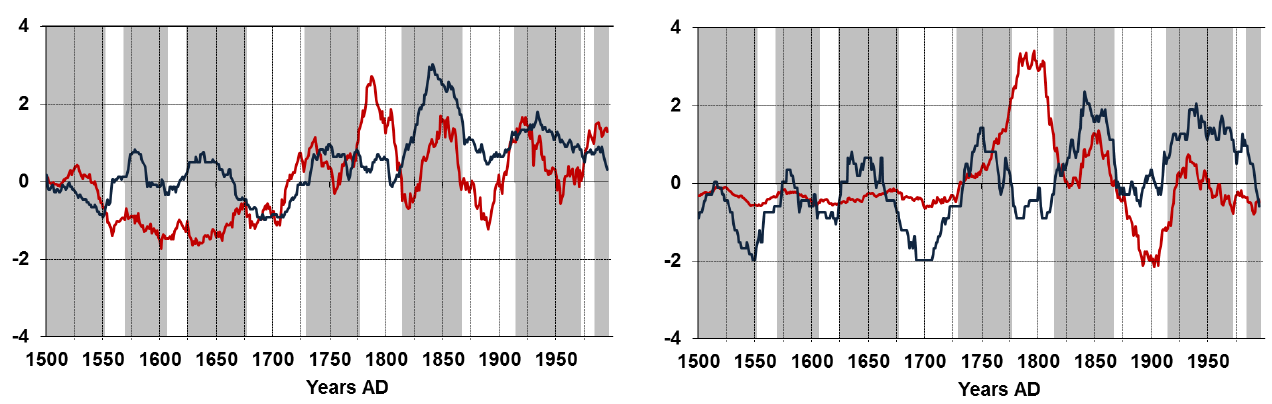
Figure 8. The z -transformed time series of 31-year running flood frequencies in the Bavarian Foreland (blue) and NAOI values (red) for the meteorological summer (JJA) (NAOI data after Luterbacher et al., 2002). Grey bars label the flood-rich periods